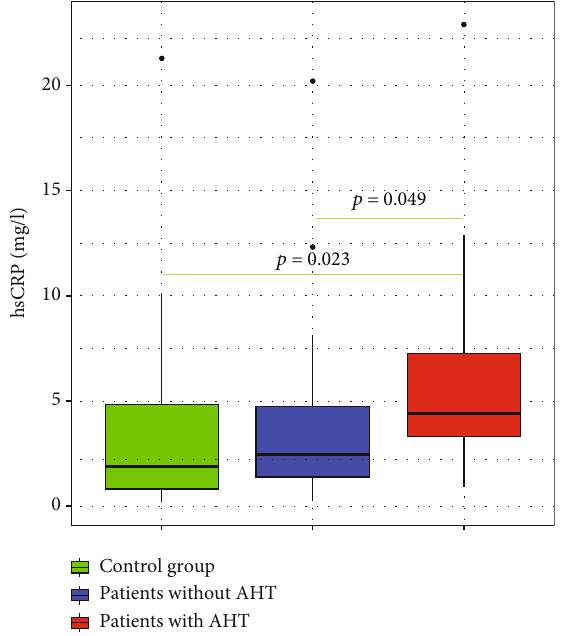
Figure 2: Comparison of the plasma levels of hs-CRP in controls, hypertensive, and normotensive OSAHS patients. hs-CRP: high- sensitivity C-reactive protein. OSAHS: obstructive sleep apnea- hypopnea syndrome. Table 2: Distribution of OAHS patients and controls according to baseline hs-CRP